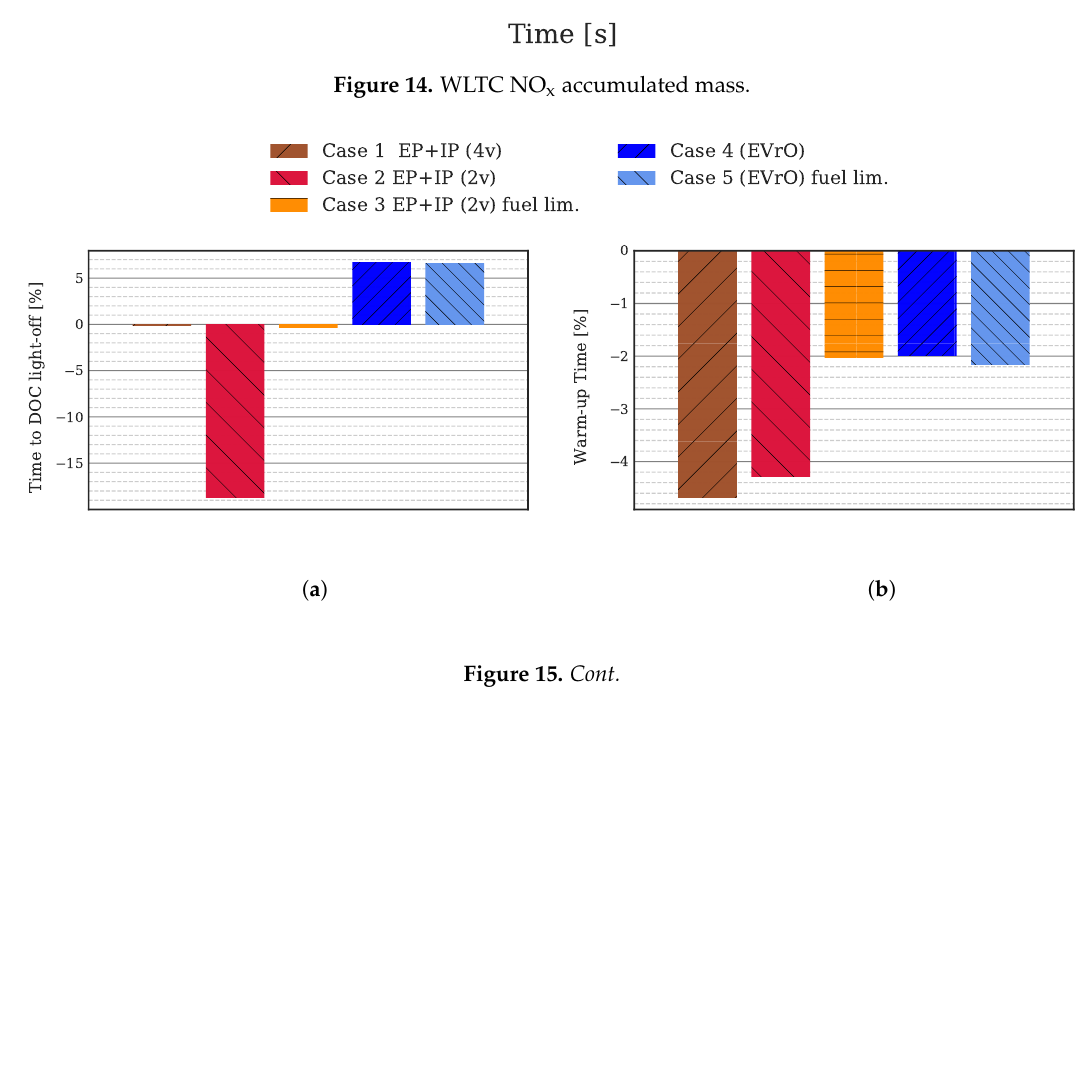
Figure 14. WLTC NO x accumulated mass.